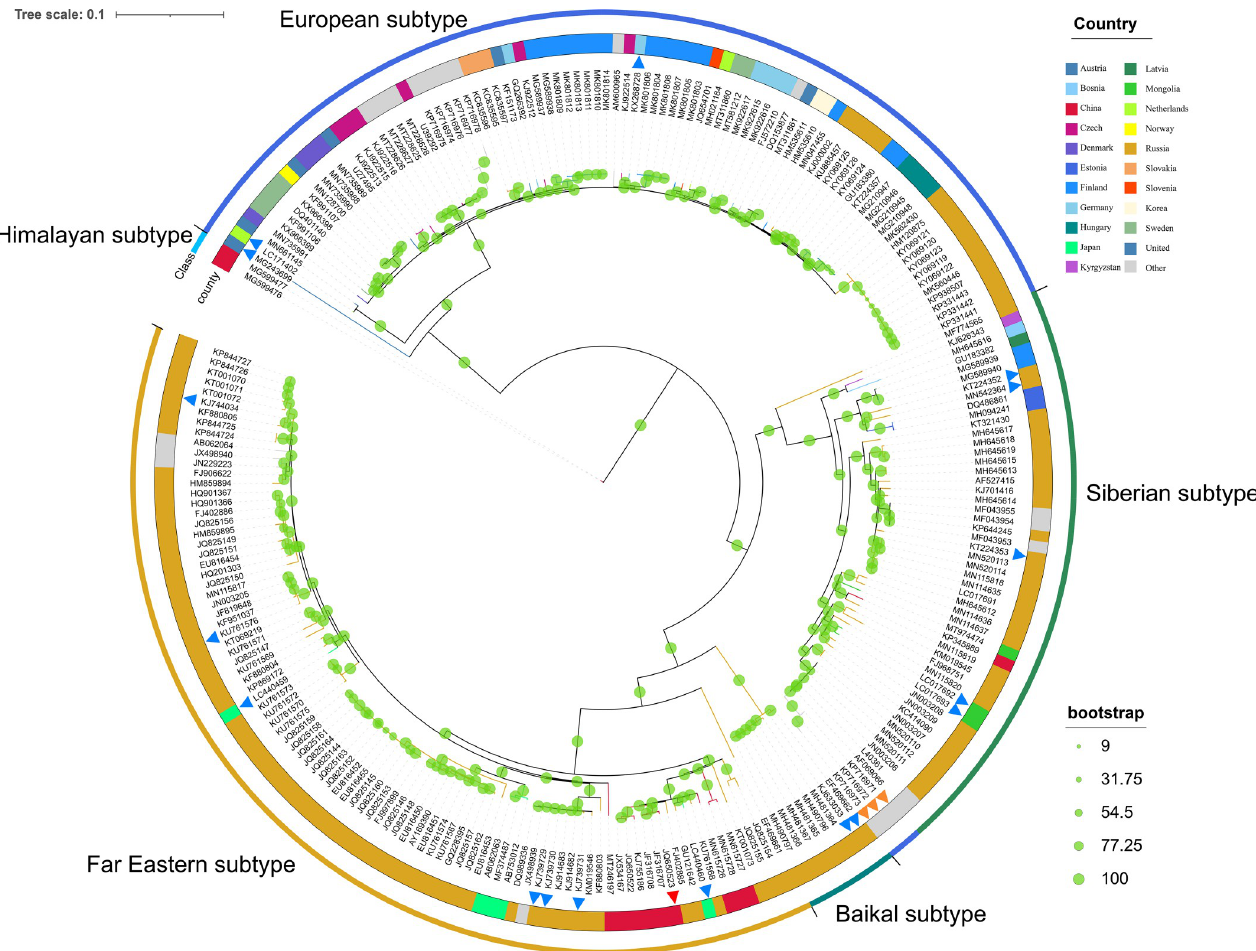
Fig 1. The phylogenic tree of 243 TBEV strains. The red triangle indicates the Senzhang strain; the orange triangles indicate three strains with subtypes inconsistent with the retrieved information, and the blue triangles indicate 17 strains without recorded subtypes but subtyped by the phylogenic analysis.